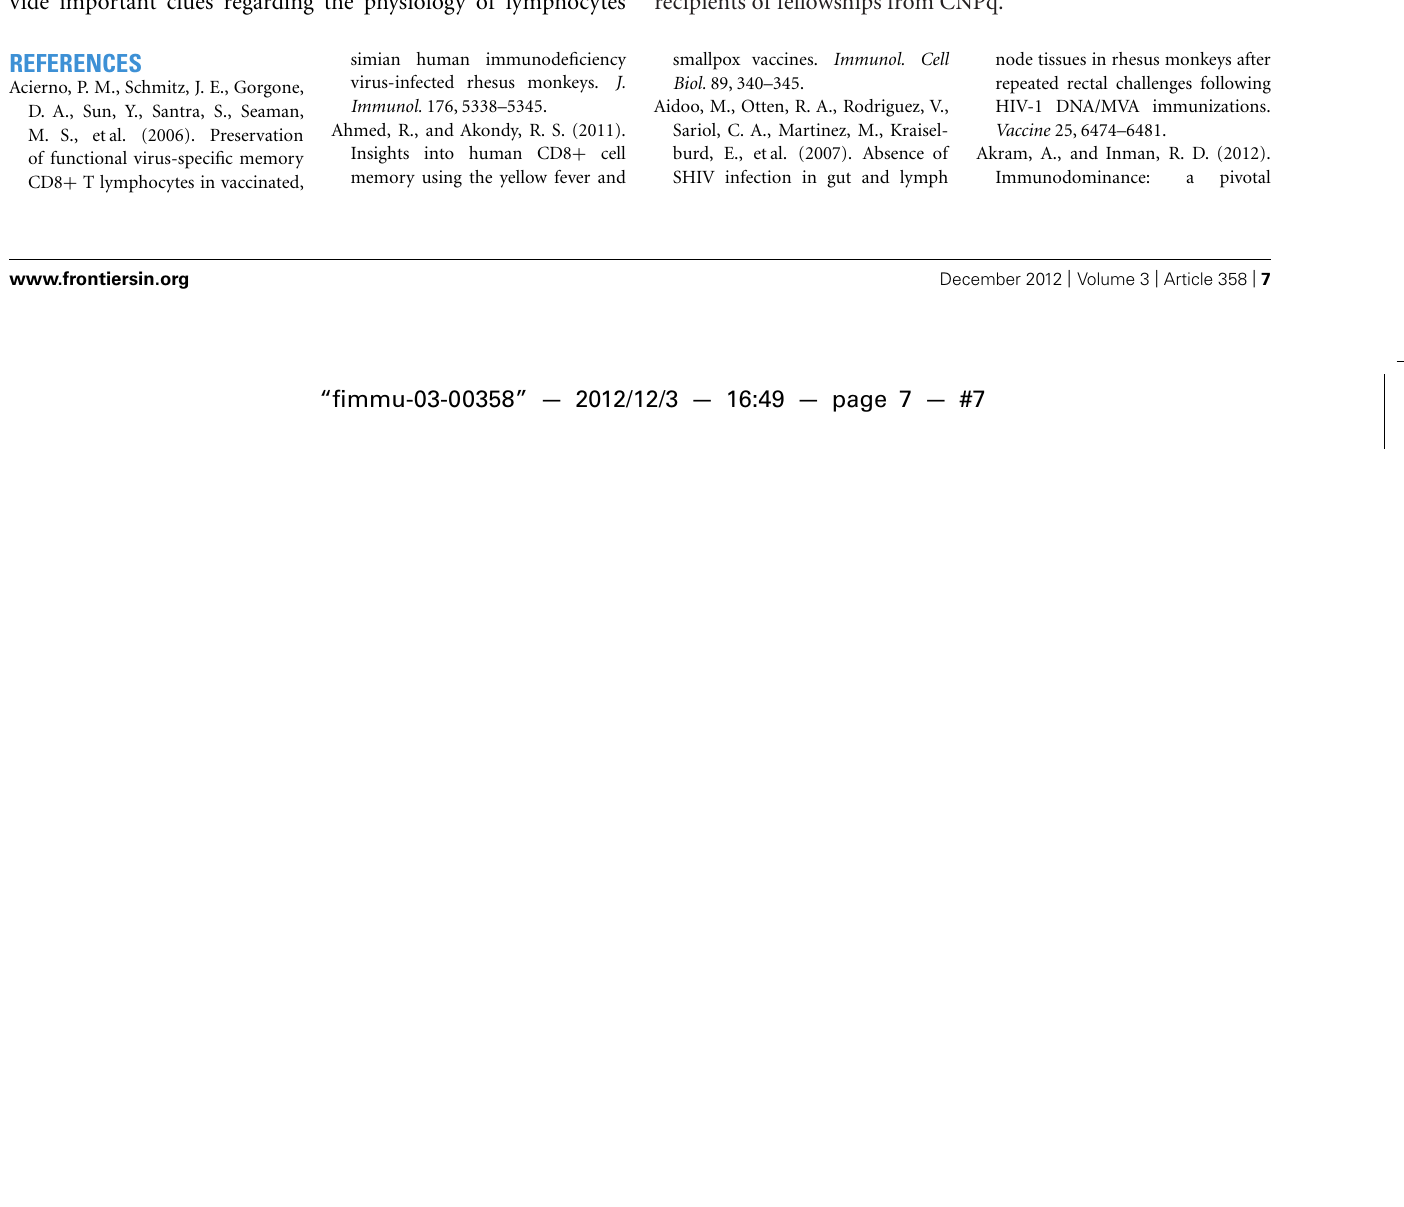
plasmid DNA (100 μ g) and boosted 21 days later with AdHu5 (2 × 10 8 ) both expressing the gene encoding the amastigote surface protein-2 of T. cruzi . Mice were infected s.c. with T. cruzi (150 blood stream